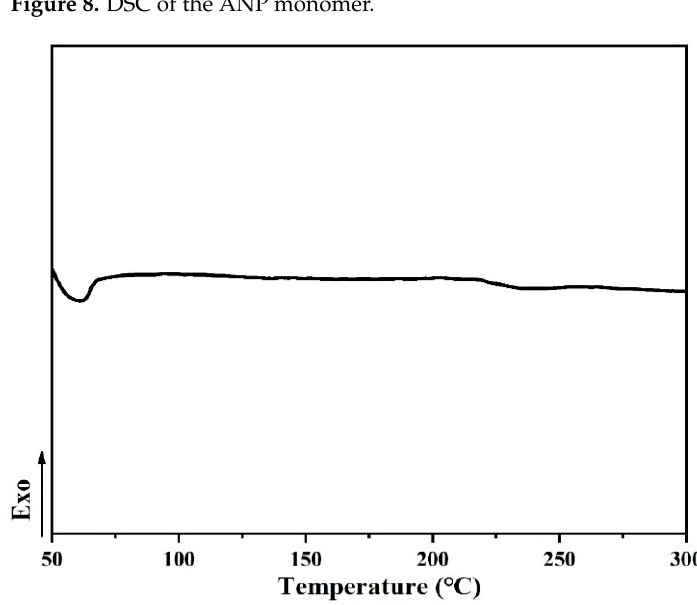
Figure 9. DSC of the DPTP monomer.